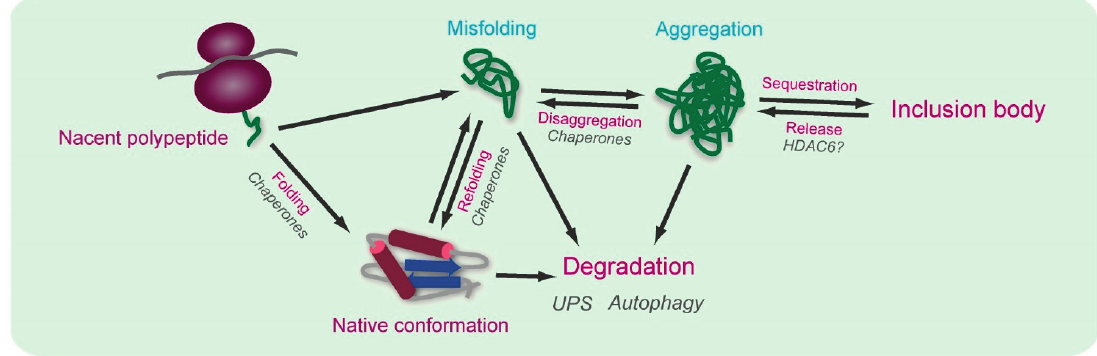
Figure 1. The proteostasis network and the course of aggregation from nascent polypeptide to inclusion body